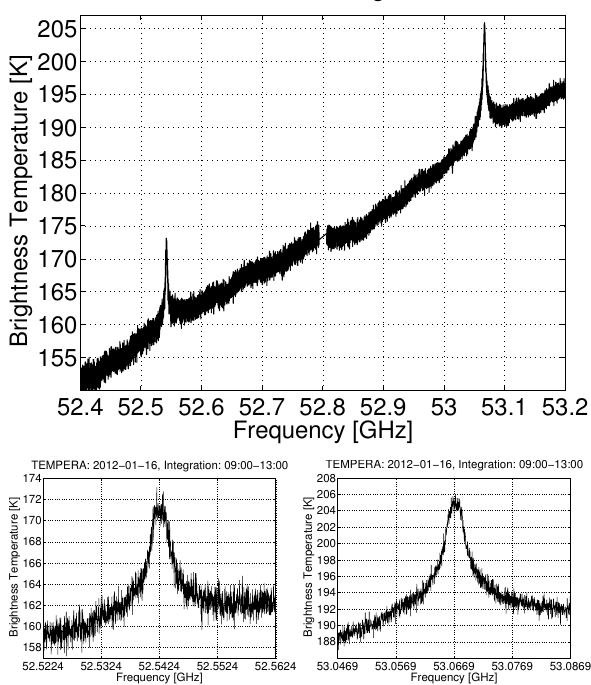
Fig. 4. Spectrum of brightness temperatures measured with TEMPERA on January 16, 2012 from 9h00- 13h00 (UT). Upper panel: The whole FFT spectrum, with all channels from 52.4 to 53.2 GHz. The gap in the middle is due to effects of the filters. Lower panels: Zoomed spectra around the first line at 52.5424 GHz and the second line at 53.0669 GHz.